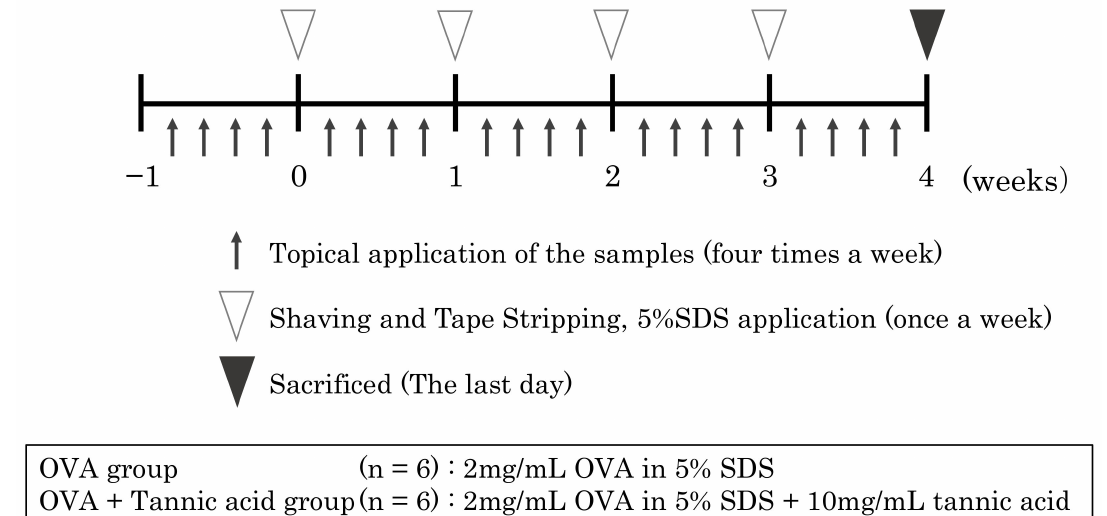
Figure 8. Schema of the percutaneous sensitization protocol in this study. Detailed information is described in the Materials and